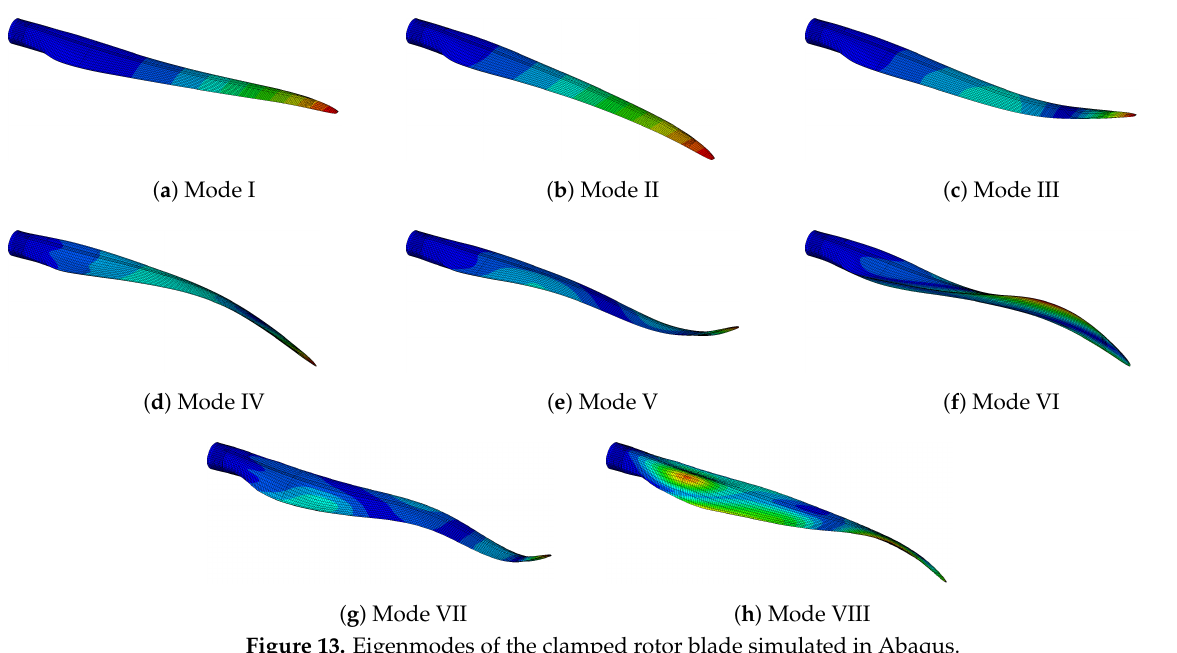
Figure 13. Eigenmodes of the clamped rotor blade simulated in Abaqus.